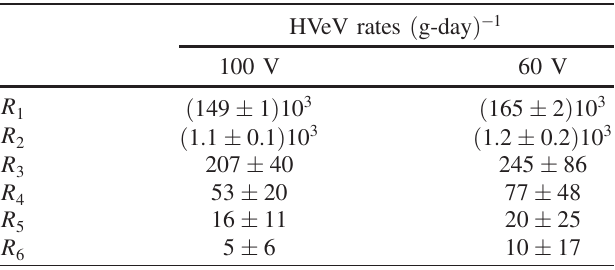
TABLE II. The rate of n e − h þ pairs, R SuperCDMS HVeV detector for two different bias voltages [71]. The uncertainty on the quoted rates corresponds to 3 σ , assuming Poisson